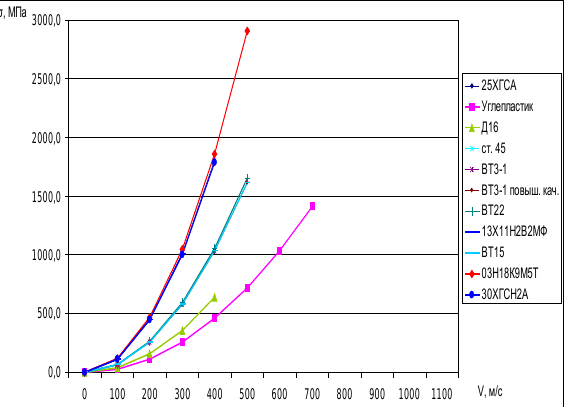
Fig. 4. Dependence o f t ensile s tress o n t he ci rcumferential speed of the grinding wheel in different